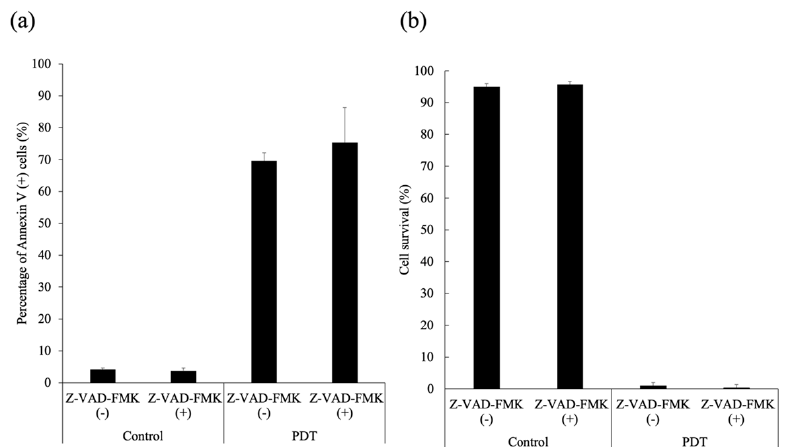
Figure 10 . Cytotoxicity in the presence or absence of a pan-caspase inhibitor. SNP cells were incubated with 8 µ g / mL glucose-conjugated chlorin e6 for 24 h in the presence ( + ) or absence ( − ) of 10 µ M Z-VAD-FMK. After rinsing with fresh medium, the cells were irradiated with 650-nm laser light (10 mW / cm 2 ; 5 J / cm 2 ). ( a ) The percentage of apoptotic cells; and ( b ) cell viability (%). The results are presented as the mean ± standard deviation.